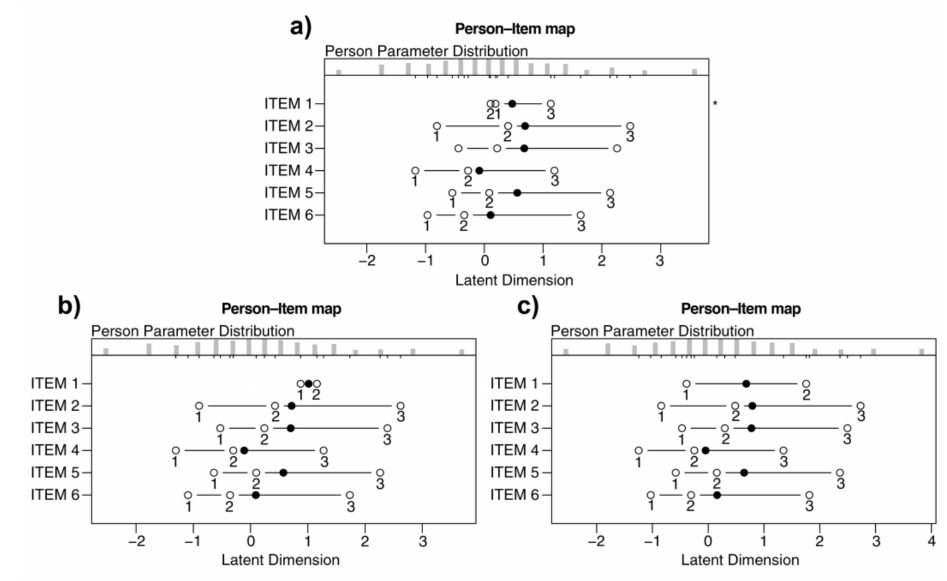
Figure 2. ( a ) Person–item map relating to the six-item solution. ( b ) Person–item map relating to the six-item solution after the first rescoring. ( c ) Person–item map relating to the six-item solution after the second rescoring. The solid circles represent the locations of the items’ discriminatory capacities. The open circles represent the thresholds. The asterisk indicates a problematic item with non-ordered